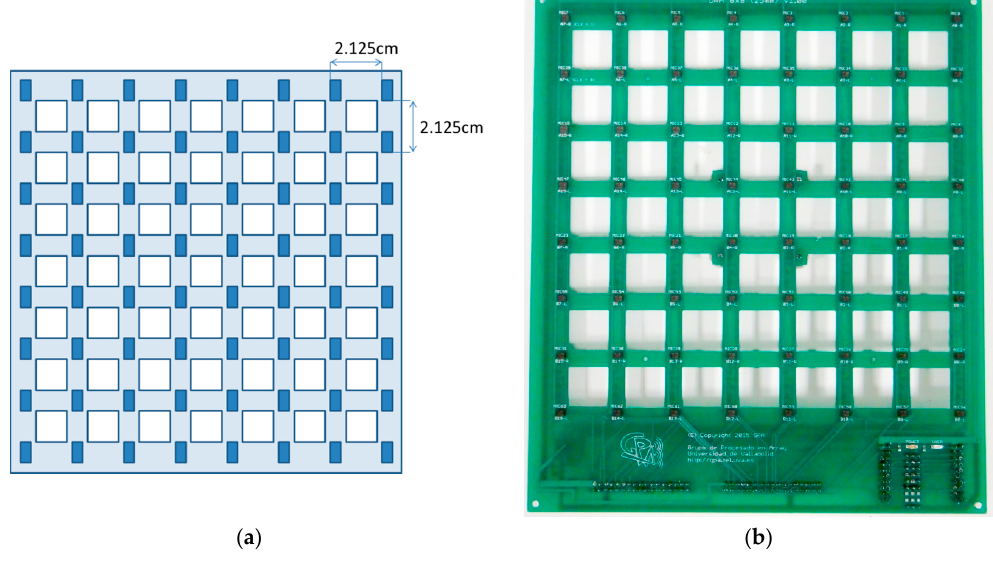
Figure 1. System microphone array: ( a ) sensor spacing; ( b ) system array.